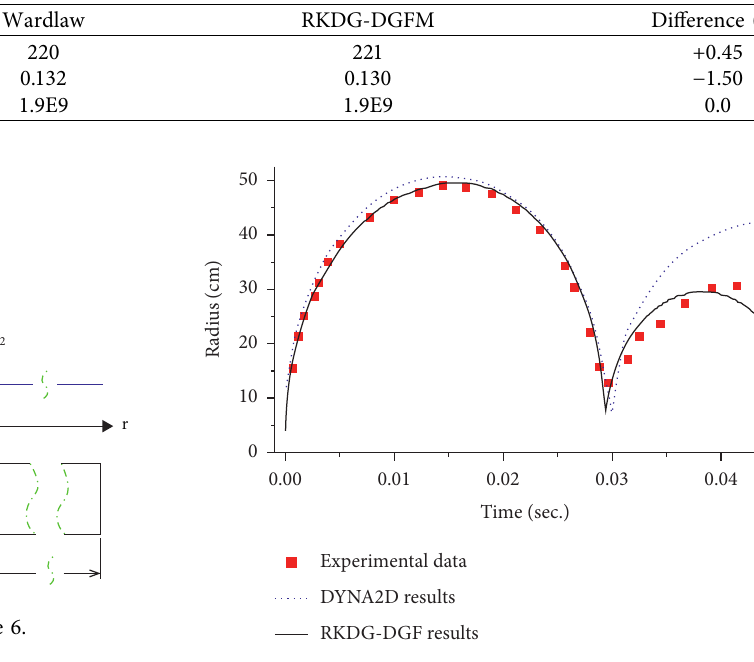
Figure 20: RKDG-DGFM results of Case 6 at 0.045